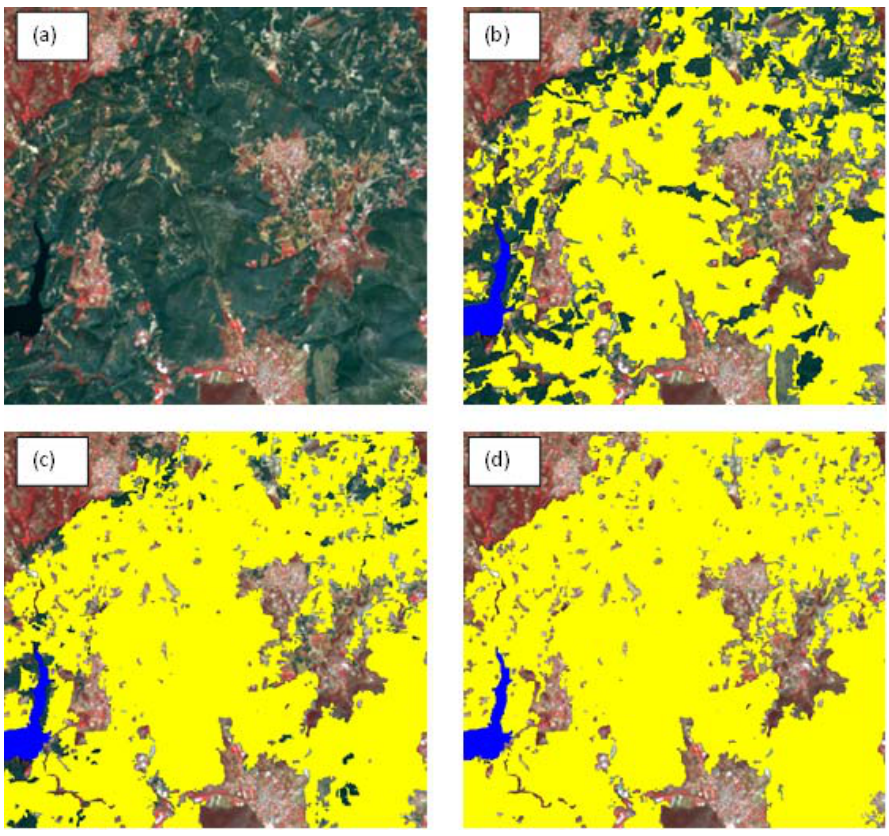
Figure 3. ( a ) Detail of the SPOT-4 HRVIR image depicting the East Attica fire (R: NIR band, G: red band, B: green band), ( b ) classification of the seed burned area objects (in yellow) and water bodies (in blue), ( c ) refinement of the classification using the grow region algorithm. Unclassified objects with a mean value of NBR less than − 0.15 were finally merged with objects classified as “burned”, ( d ) final classification of the burned